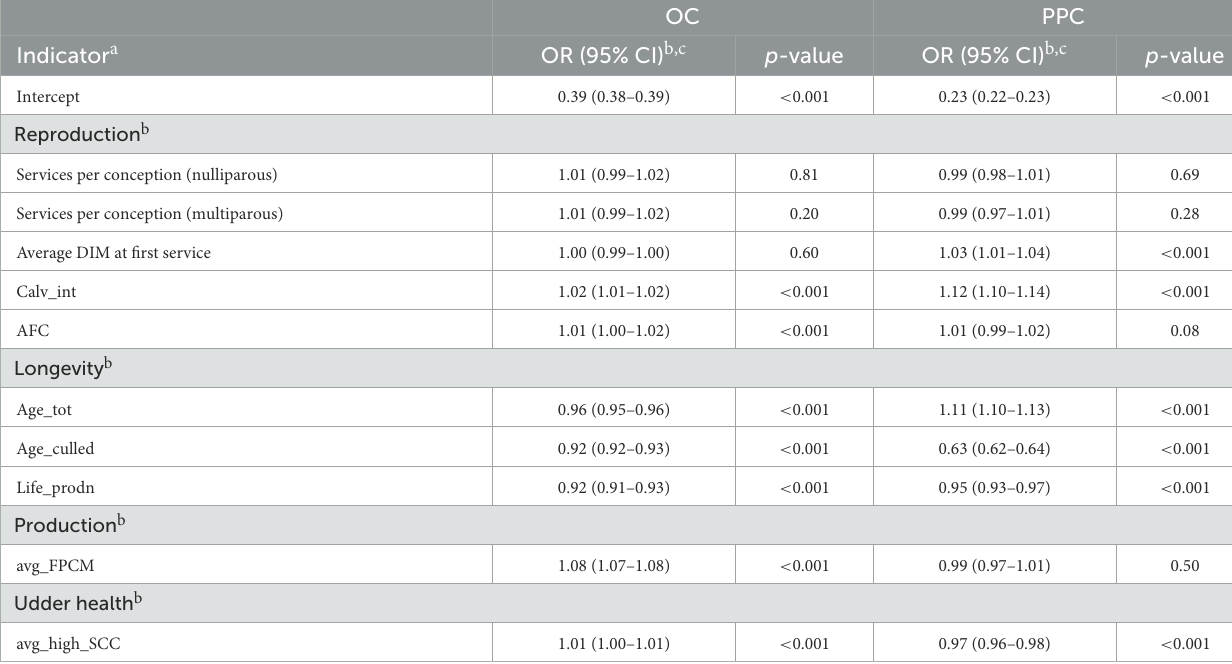
TABLE 2 Summary of results: multivariable fractional logistic regression models with overall culling (OC) or primiparous–primiparous culling proportion (PPC) as dependent variable against scaled herd performance indicators in four